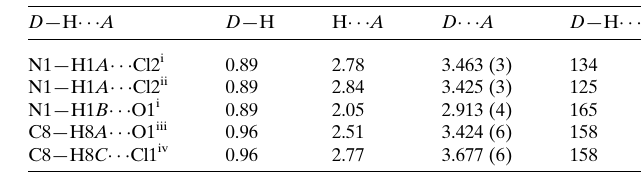
Table 1 Hydrogen-bond geometry (A˚ , (cid:4) ).